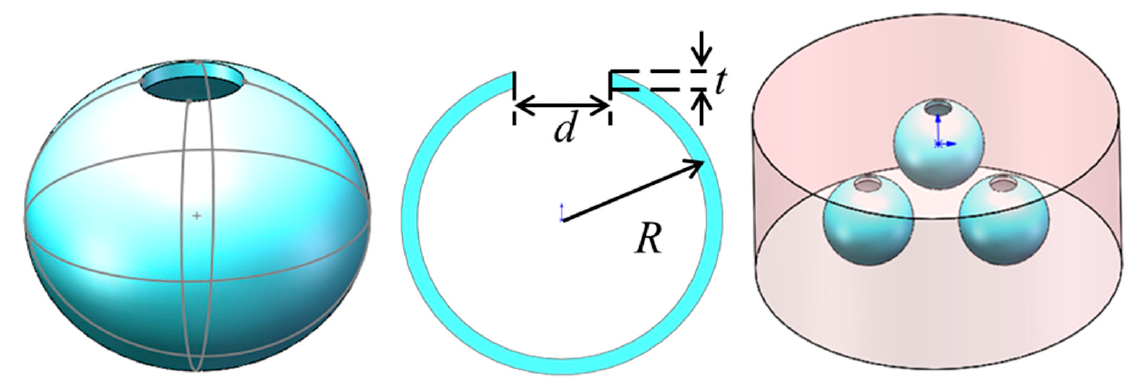
Figure 1. The schematic diagram of SHS unit cell.